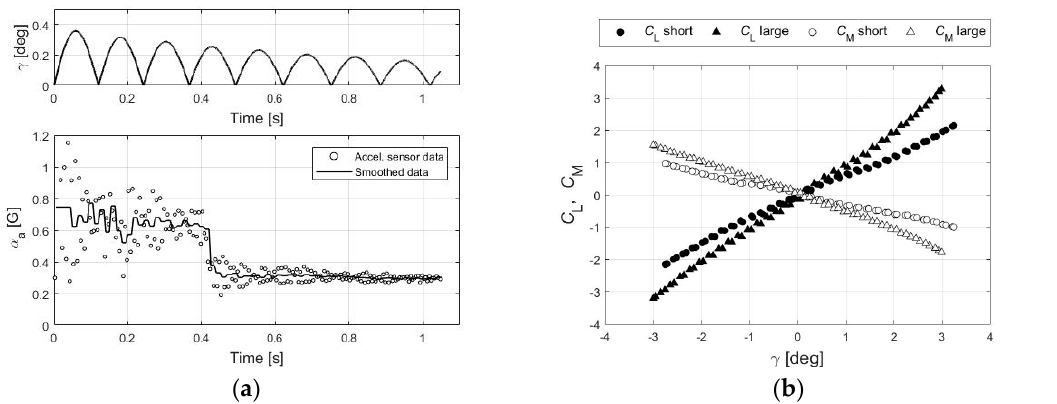
Figure 4. ( a ) Superior part: time evolution of γ for a shot with initial velocity V 0 = 56.4 ms − 1 , bottom: arrow’s deceleration in the axial component measured with the acceleration sensor; ( b ) C L and C M as a function of γ at Re = 1.0 × 10 4